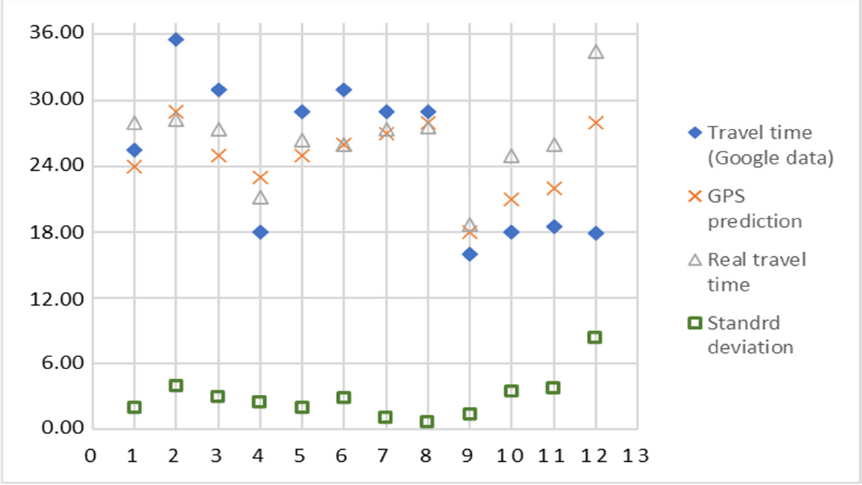
Figure 7. Google Cloud data from predicted travel times for three routes over a one-month period.